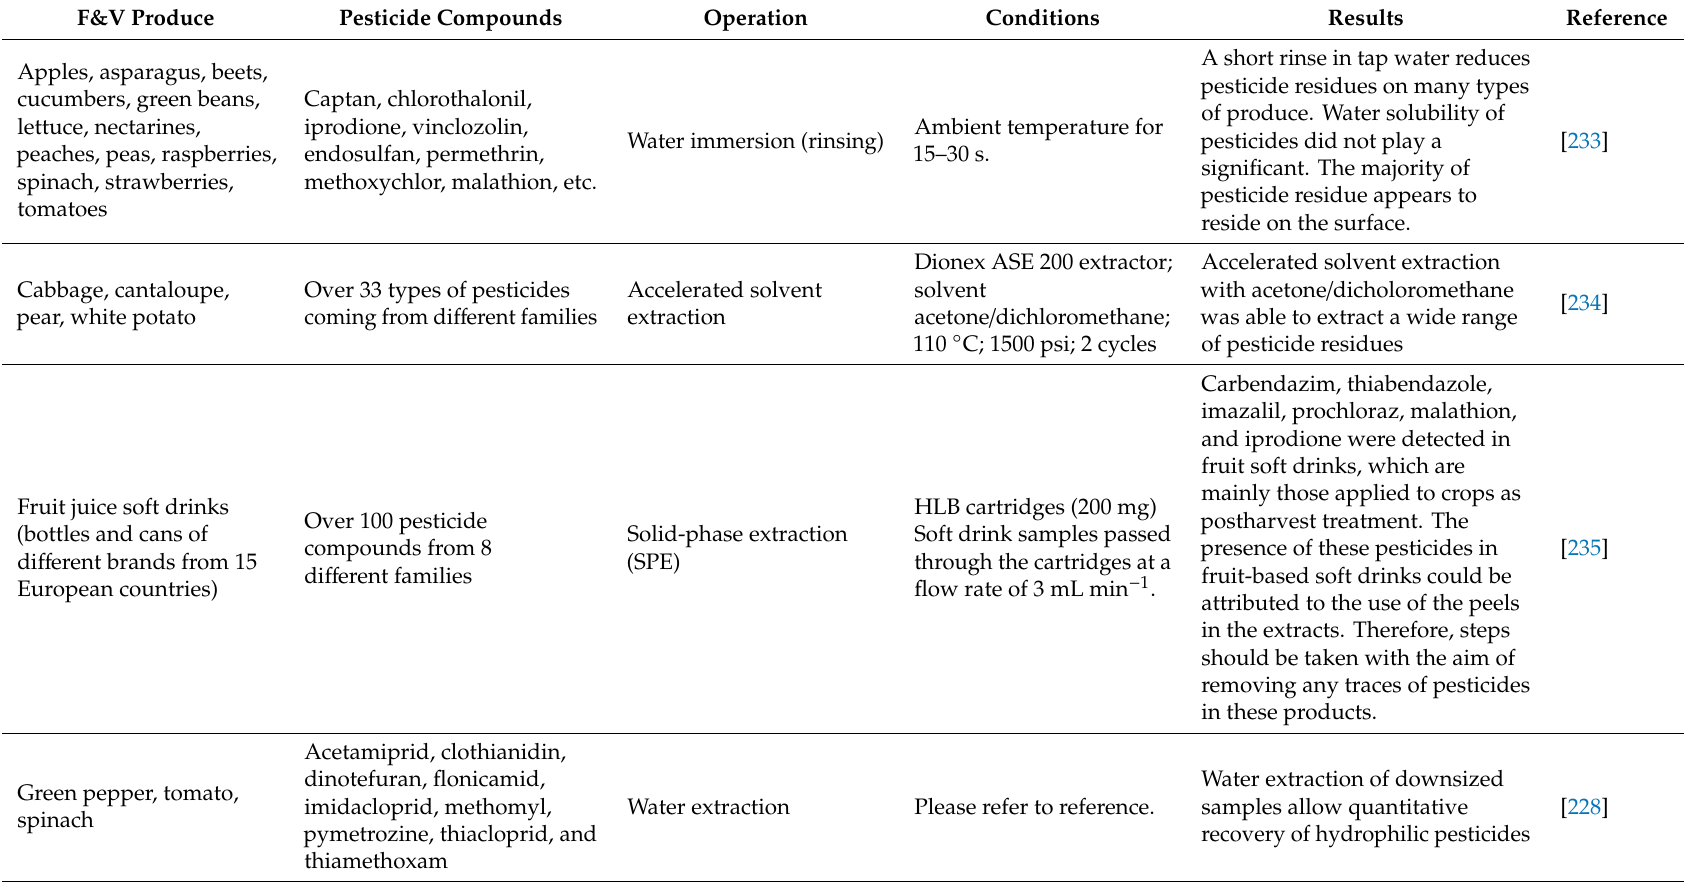
Table 7. E ff ect of extraction on residual pesticides in plant-based foods (mainly fruits and vegetables but also including leaves for